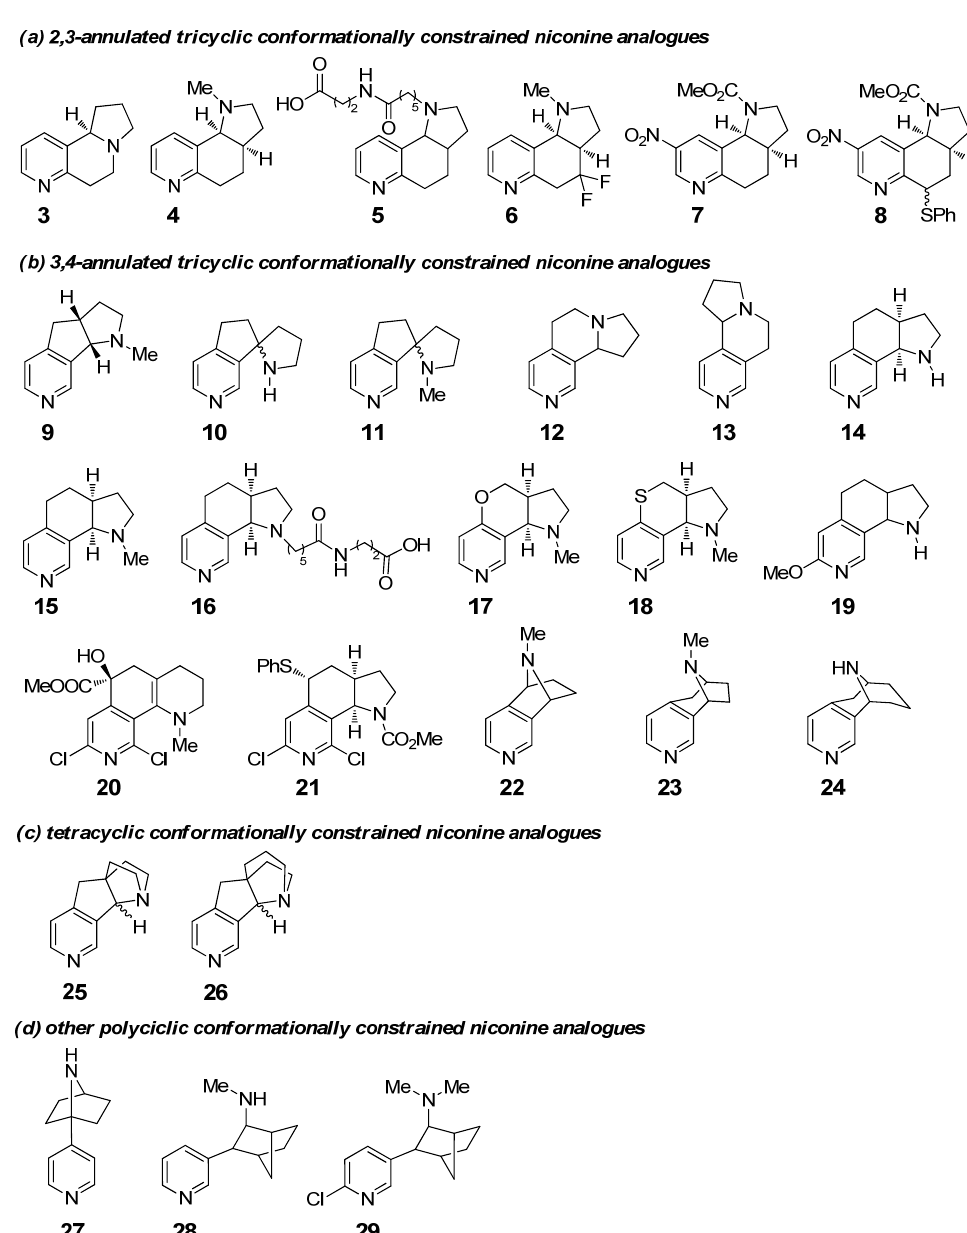
Figure 3. Conformationally restricted analogues of nicotine prepared by synthetic pathways in- volving one or more catalytic processes: ( a ) 2,3-annulated tricyclic derivatives ( 3 – 8 ); ( b ) 3,4-annulated tricyclic derivatives ( 9 – 24 ); ( c ) tetracyclic derivatives ( 25 – 26 ); and ( d ) other polycyclic structures ( 27 – 29